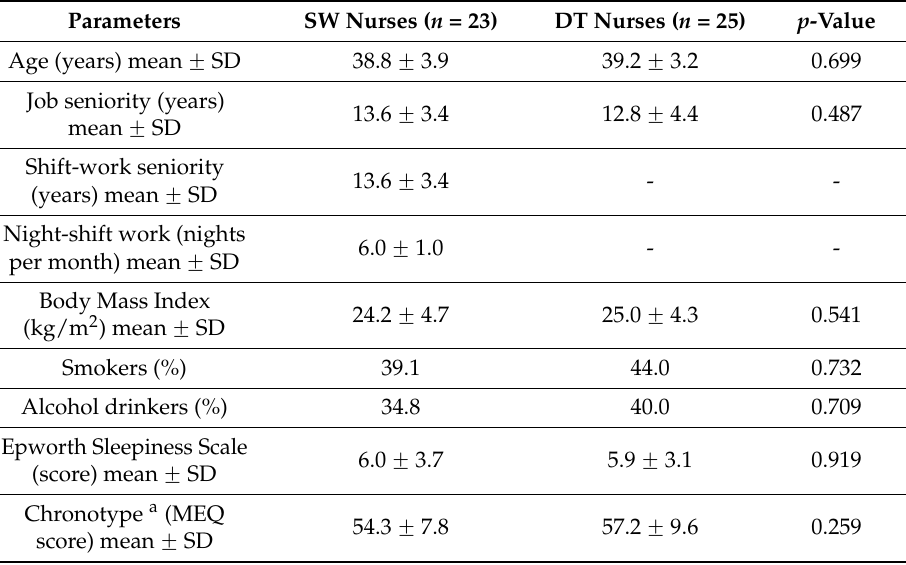
Table 1. Demographic characteristics, Epworth Sleepiness Scale scores, and Chronotype (MEQ score) of shift-working (SW) and daytime (DT)